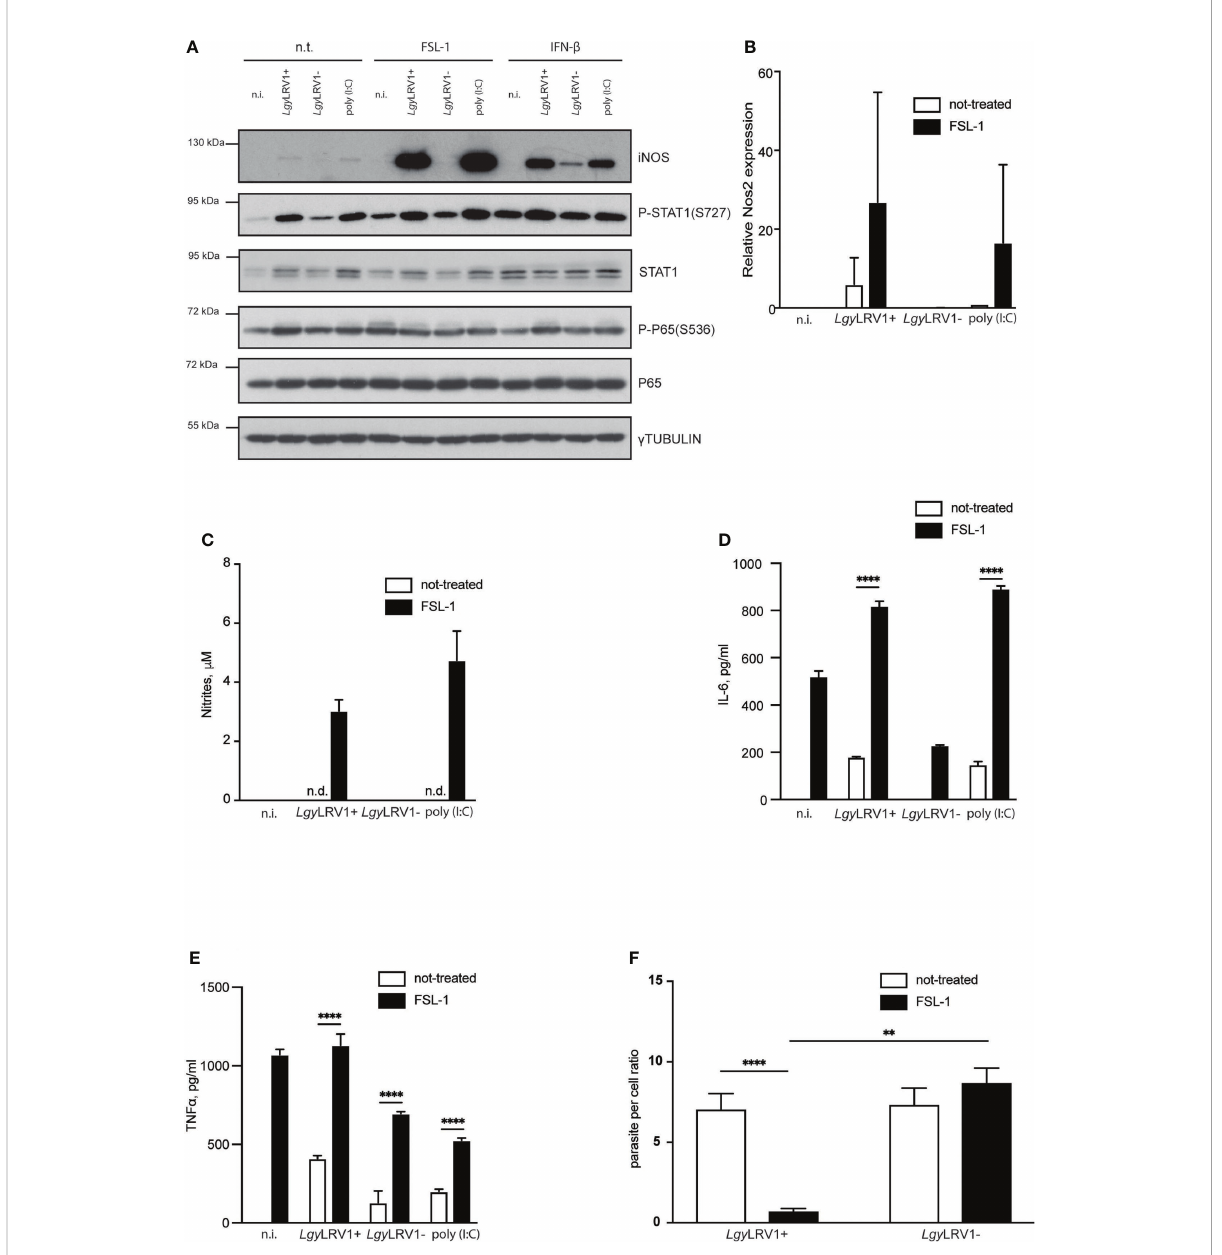
FIGURE 2 External NF- k B activation boosts Lgy LRV1+ triggered iNOS induction and rescues BMDMs from infection. (A) WT BMDMs were infected with Lgy LRV1+ or Lgy LRV1- (MOI 10), left untreated, or stimulated with poly (I:C) (2 m g/ml) for 12h. Additionally some conditions were treated with FSL-1 (10 ng/ml), or IFN- b (500 U/ml), or left untreated. Total cell lysates were analyzed by western blot for iNOS, P-STAT1(S727), STAT1, P65, P- P65(S536) and g -tubulin expression. (B) WT BMDMs were infected as in (A) . RT-PCR was used to measure L32 -normilized Nos2 expression. (C – F) - WT BMDMs were infected as in (A) for 48h. Levels of parasitemia were measured by high content microscopy (F) . SNs were collected and levels of nitrites (C) , IL-6 (D) and TNF- a (E) were analyzed by Griess assay and ELISA respectively. Data show mean ± SEM (F) , or SD (B – E) from a representative of three independent experiments. Representative blot is shown from at least three independent experiments in (A) . Data were analyzed using unpaired Student ’ s t test in F or Sidak ’ s multiple comparisons (D, E) . Not signi fi cant (NS), **p < 0.01, and ****p < 0.0001. n.i. – non-infected. n.t. – non-treated. n.d. - not